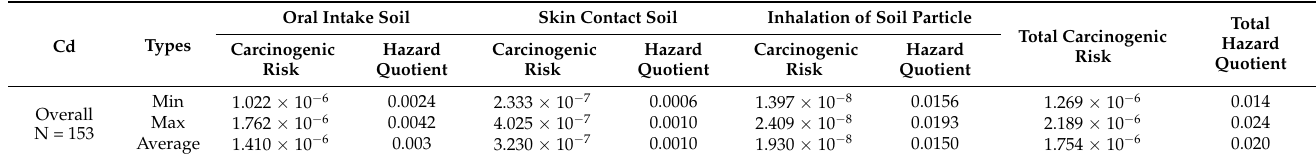
Table 8. The results of risk of Cd in the coalification area.